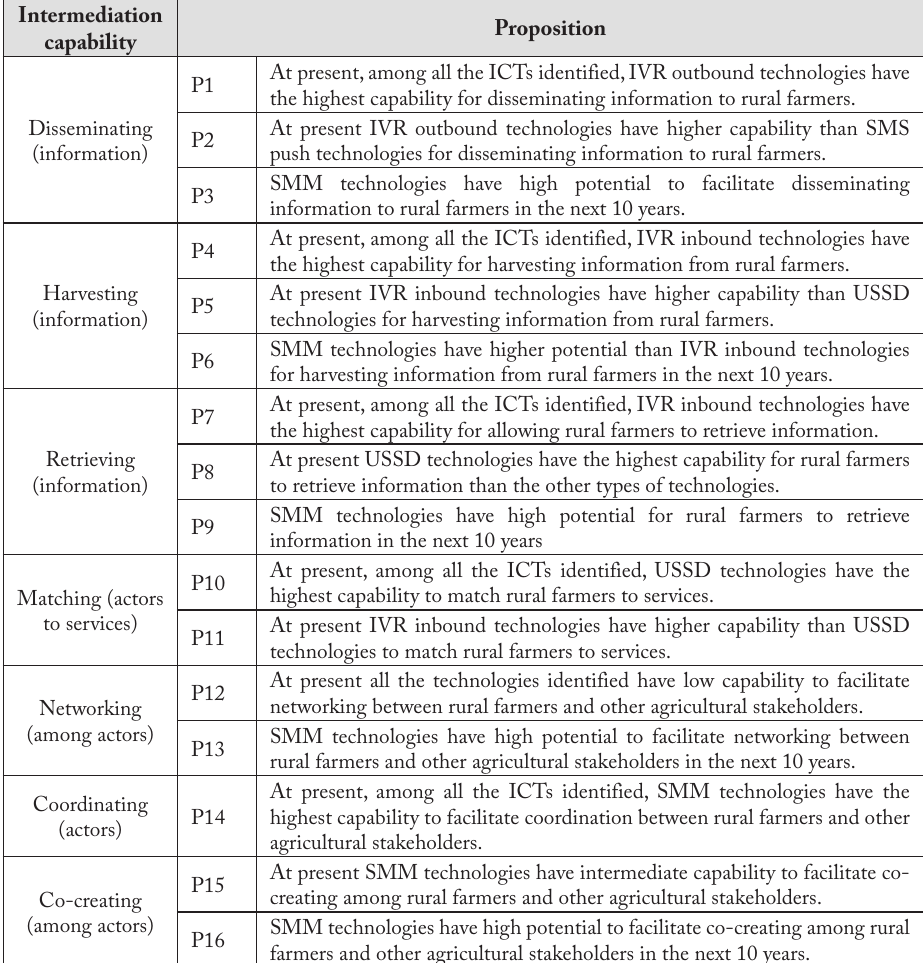
Table 5: The 16 propositions (P1 to P16) used in second round of consensus-building